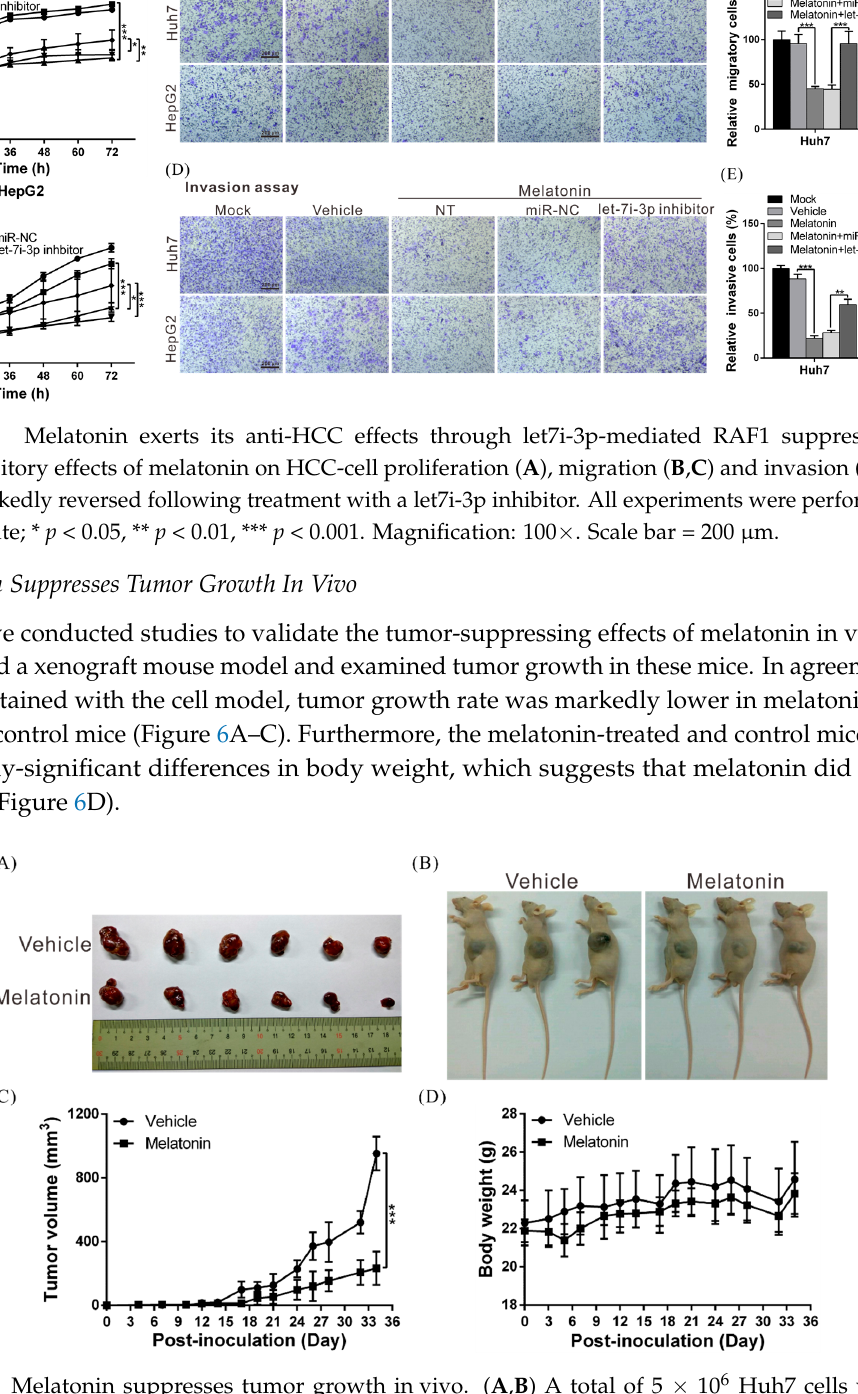
Figure 6. Melatonin suppresses tumor growth in vivo. ( A , B ) A total of 5 × 10 6 Huh7 cells were subcutaneously implanted into the left and right flank regions of mice, and the mice were divided into two groups ( N = 6/group); one group was injected with 100 µL of melatonin (at a dose of 40 mg/kg body weight), and the other was injected with an equal volume of vehicle (dimethyl sulfoxide), five days per week. Here, representative images of the tumor xenografts at four weeks after implantation are shown. ( C ) Tumor volumes were calculated every three days after injection. The volume of each tumor was calculated thusly: volume = length × width 2 × 0.5. Bars indicate SD; *** p < 0.001. ( D ) Body weights were determined every three days after injection.